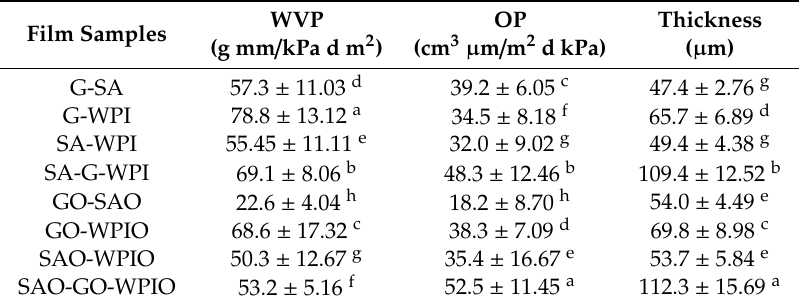
Table 4. Water vapour permeability and oxygen permeability of laminated films a